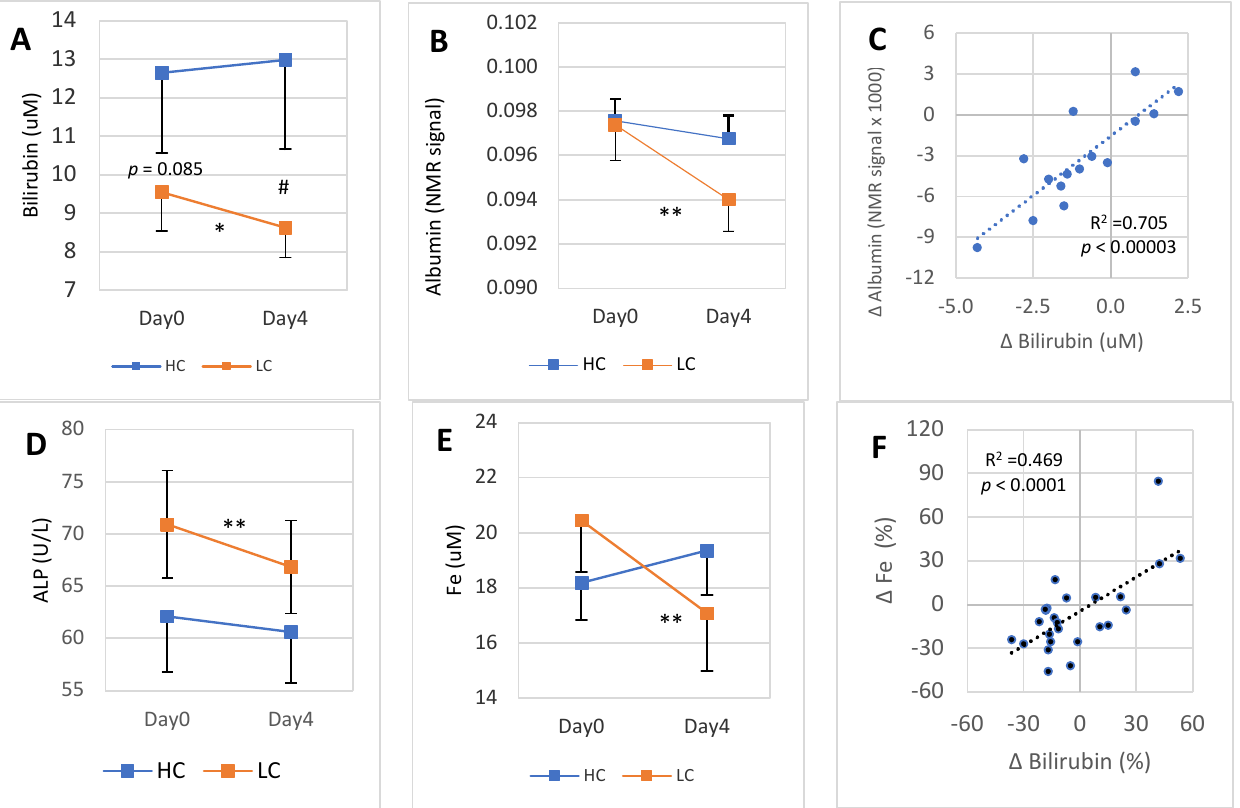
Figure 4 . 4-day DGA regimen activates hepatic bilirubin metabolism and Fe storage in the LC sub- group: ( A ) mean (±SEM) blood bilirubin in the HC and LC subgroups separately, ( B ) mean (±SEM) blood albumin in HC and LC subgroups separately, ( C ) cross correlation between intraindividual 4-day molar changes of albumin (vertical scale) and bilirubin (horizontal scale) in the LC subgroup. ( D ) mean (±SEM) blood ALP in the HC and LC subgroups separately, ( E ) mean (±SEM) blood Fe in the HC and LC subgroups separately, and ( D ) cross correlation between intra-individual four-day percent changes of Fe (vertical scale) and bilirubin (horizontal scale) in the whole group. Notes: * and ** indicate paired t -test from Day0 to Day4, # indicates non-paired t -test between the bilirubin concentration on Day4. In ( C , F ), the p -values are based on an F-test.